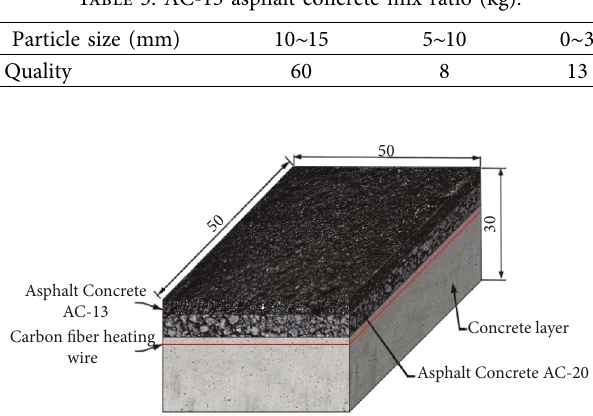
Figure 1: Three-dimensional model of an asphalt concrete spec- imen (cm).